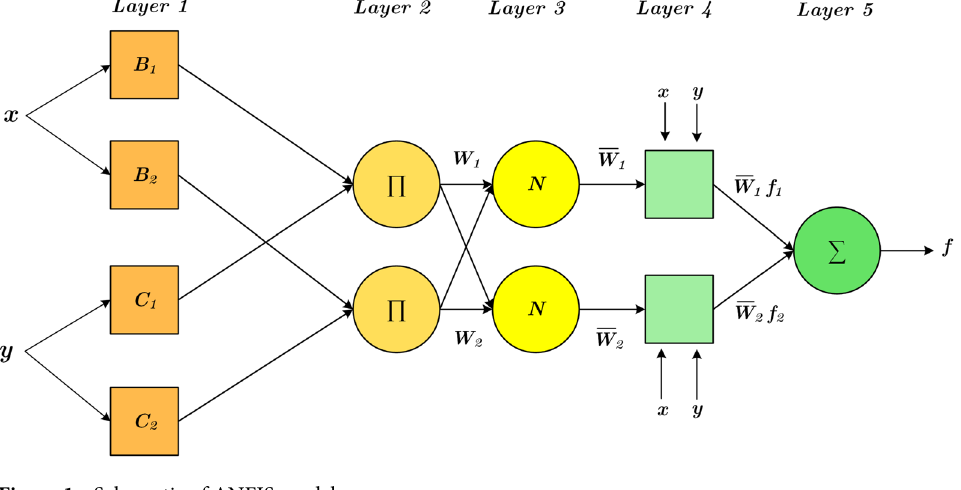
Figure 1. Schematic of ANFIS